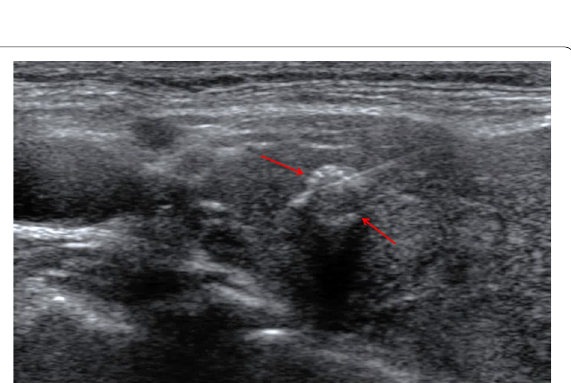
Fig. 3 The ultrasound-guided fine-needle aspiration from an isoechoic nodule with incomplete peripheral echogenic foci and a diameter of 8 mm (ACR-TIRADS-4, ATA-2015-Low suspicion, K-TIRADS-3), which was proved by cytology to be a nodular goiter